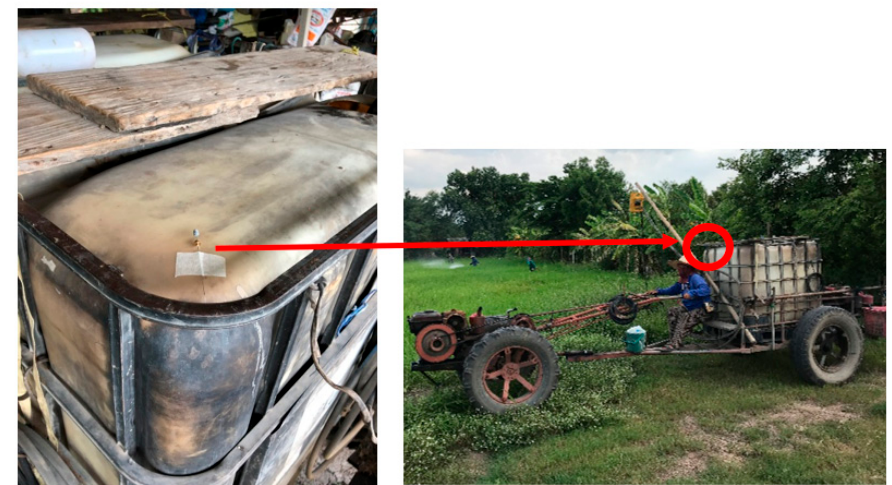
Figure 3 SPME sampling application. Figure 3. SPME sampling